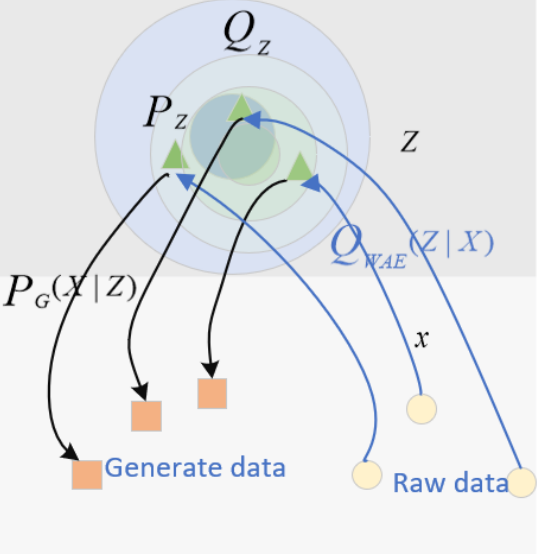
Figure 4. Reconstruction diagram of